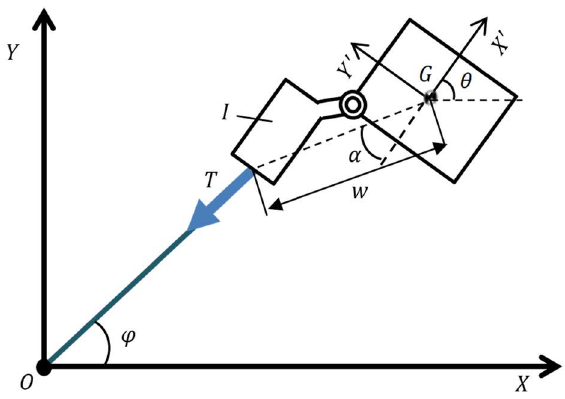
Figure 3. Model of the TSMD when the tether is stretched [21].